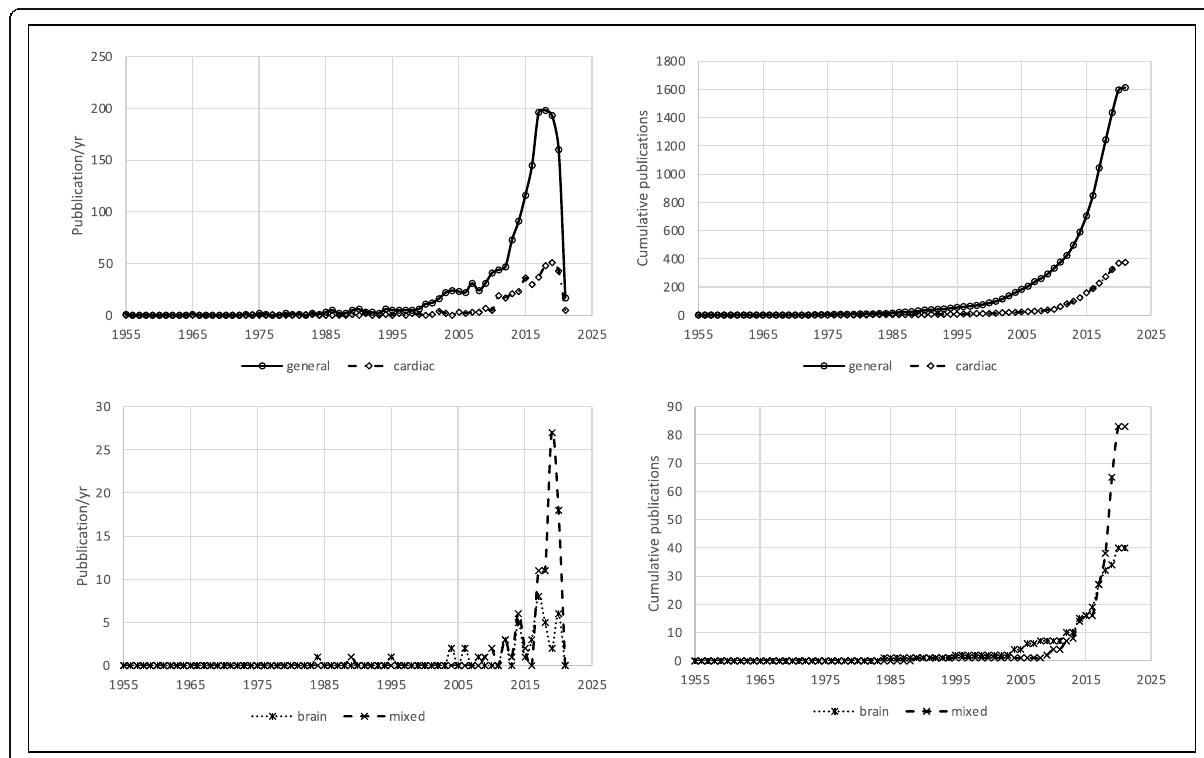
Fig. 6 Number of papers on PND published annually (left) and cumulatively (right) according to surgical